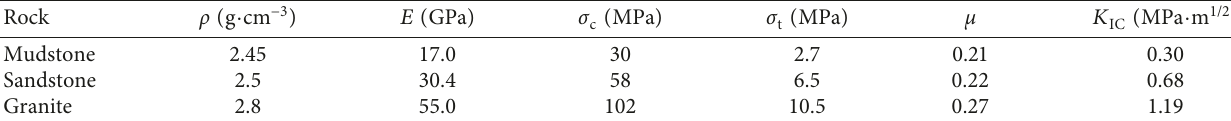
Table 2: Physical and mechanical parameters of